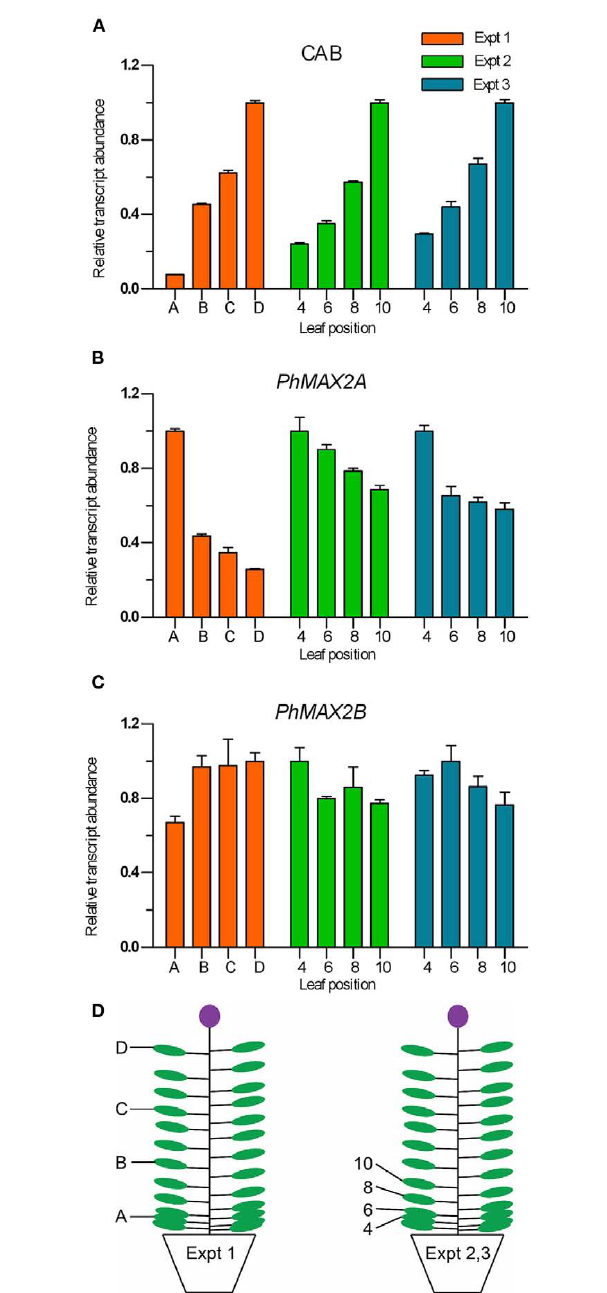
FIGURE 6 | PhMAX2A and PhMAX2B transcript abundance in petunia leaves. In the first experiment (Experiment 1) leaves were sampled from four positions on 8-week-old plants. Position A is 1cm above the cotyledons, position D is two nodes below the first flower, positions B and C are equally spaced between these samples. In the second and third experiments (Experiments 2 and 3) leaves were sampled at nodes 4, 6, 8, and 10 on 9-week-old plants. Relative transcript abundance was rescaled against the sample with the greatest expression for each gene in each experiment (A) CAB, (B) PhMAX2A , (C) PhMAX2B .Values are means ± SEM and indicate technical variation over triplicate reactions. (D) Diagram showing the sampling methodology, for simplicity branches and spiral phyllotaxy of leaves are not shown.